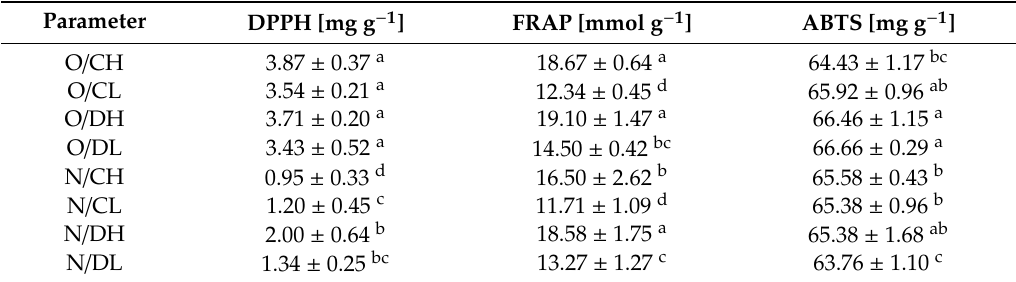
Table 3. Antioxidant activity of GB.